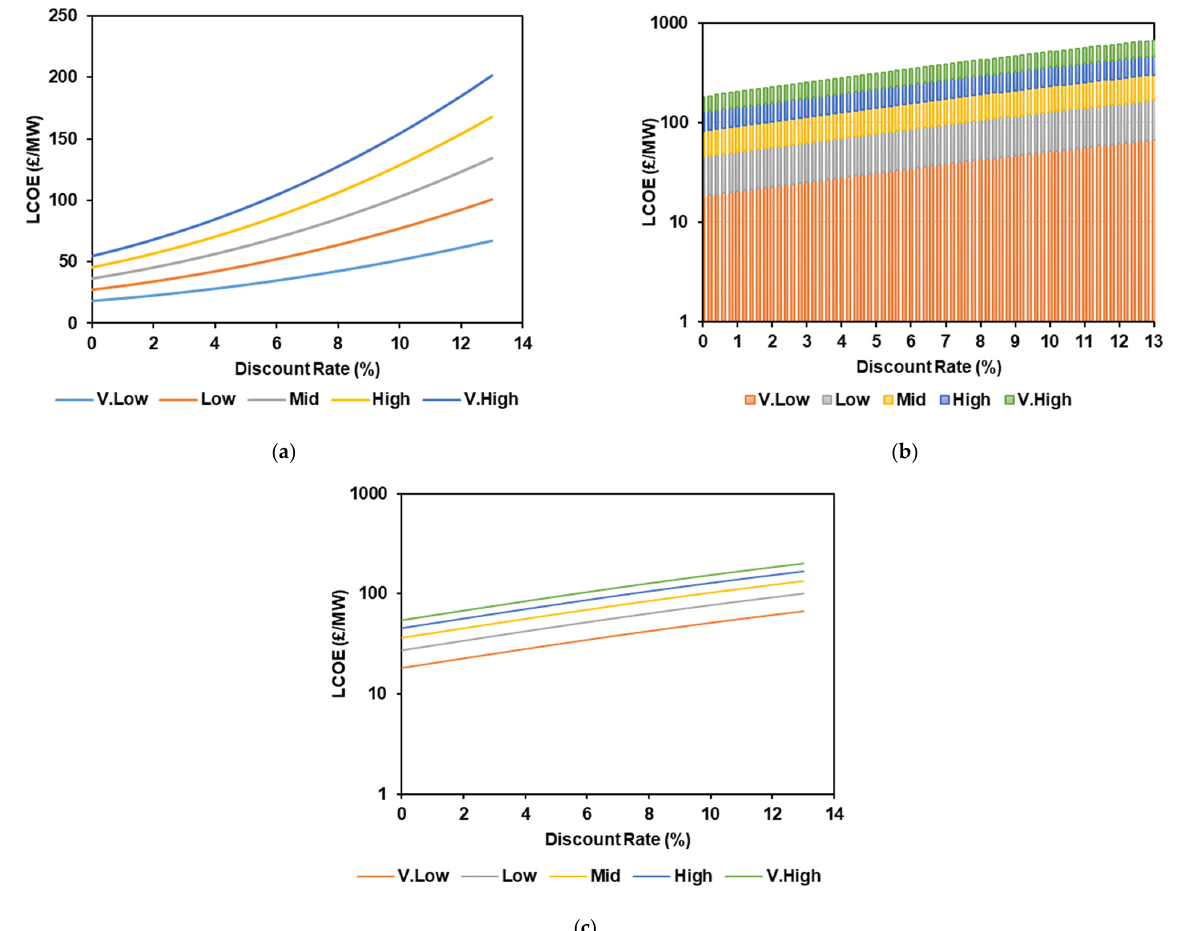
Figure 7. ( a ) 25-year scenario vs. discount rate; ( b ) 25-year range, and ( c ) Year sensitivity (LCOE difference of 15–25 year).